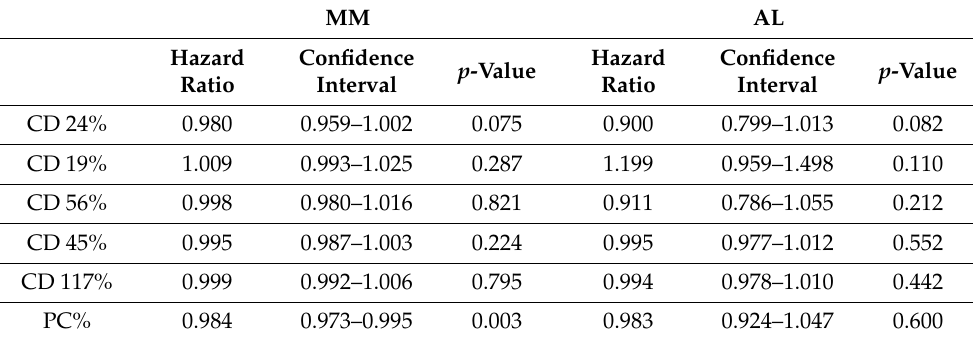
Table 3. Comparative significance values of CDs correlated to MM and